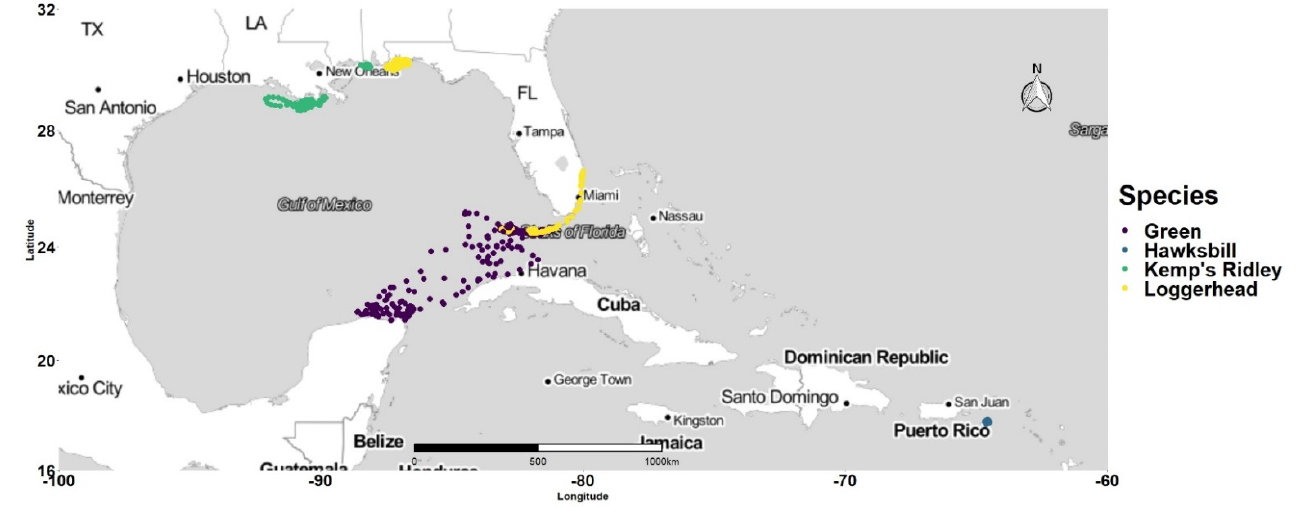
Figure 2. Map of study area showing state-space model (SSM) points by species. Turtle species are denoted by color.